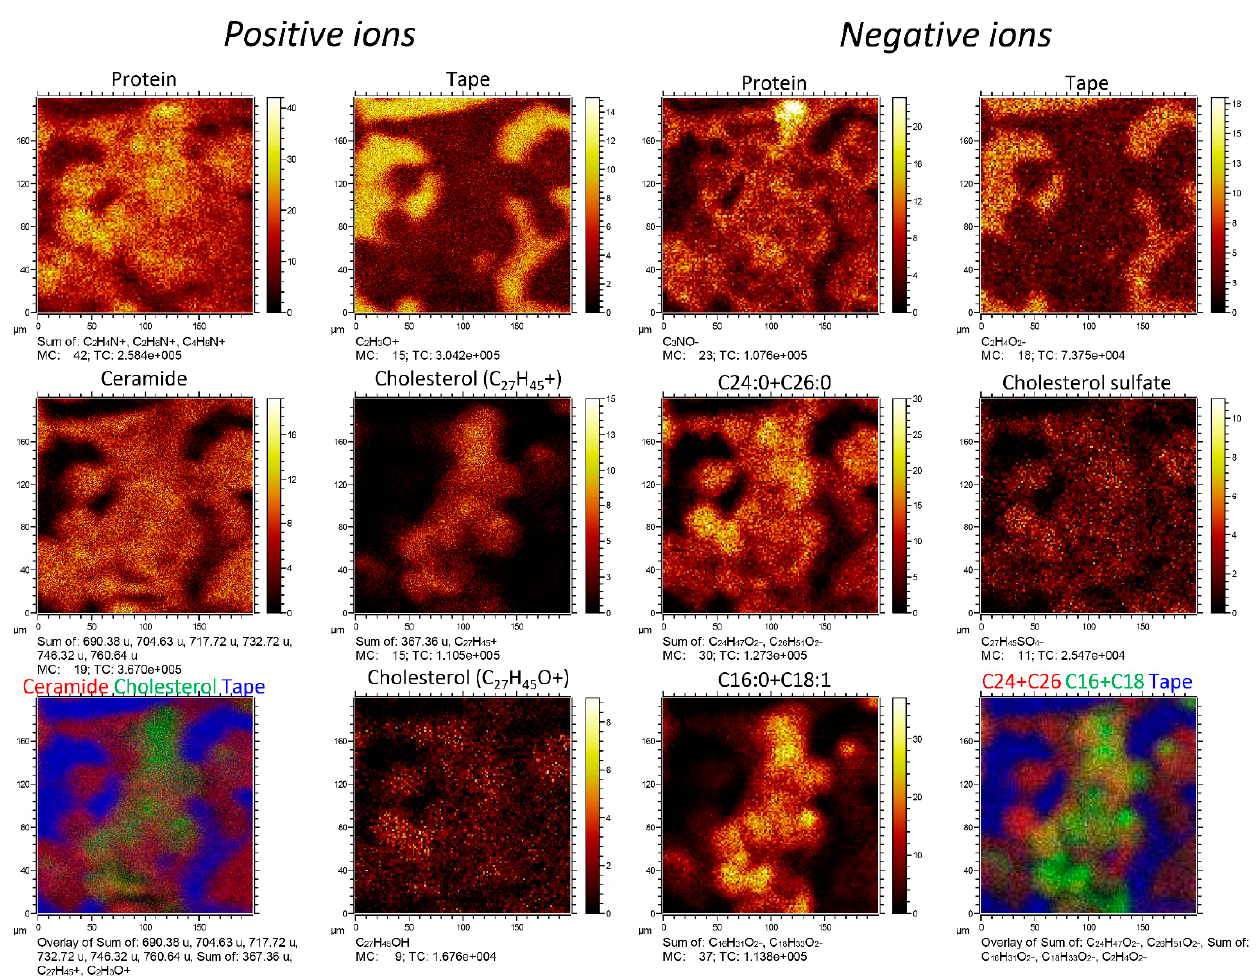
Figure 4. ToF-SIMS ion images of a single corneocyte layer on tape substrate prior to argon cluster sputtering. Positive and negative ion data were acquired in separate measurements but from the same sample position.